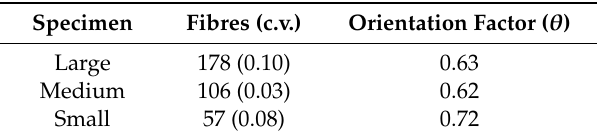
Table 3. Average number of fibres in the fracture surface with their coe ffi cient of variation (c.v.) and the overall orientation factor ( θ ) for each specimen